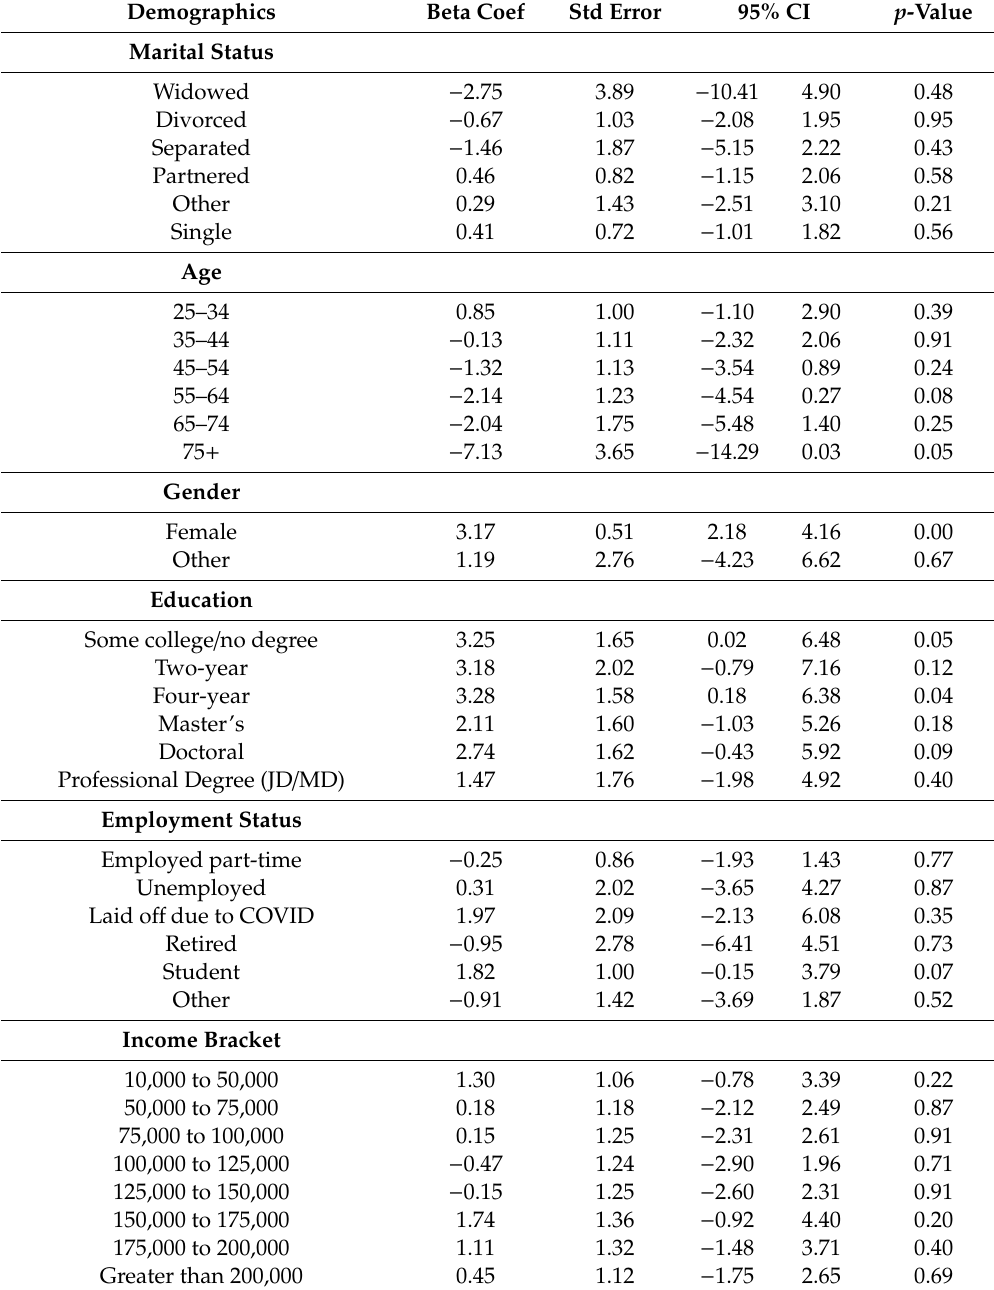
Table 2. Worldwide associations between sociodemographic variables and perceived stress during the COVID-19